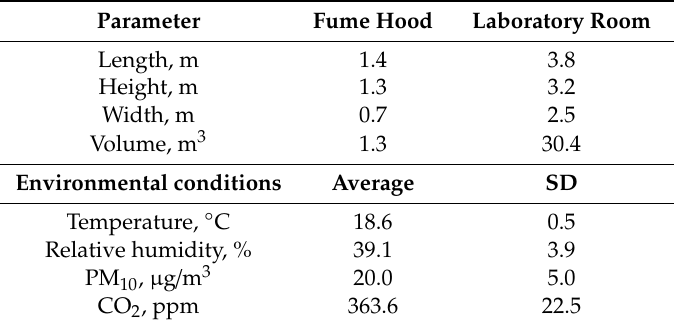
Table 2. Characteristics of laboratory room, fume hood, and environmental